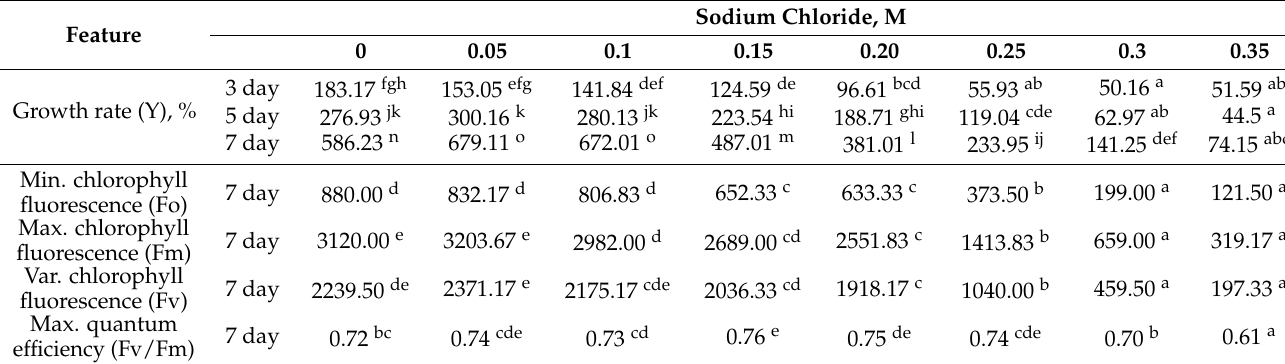
Table 2. The growth rate (Y), minimum chlorophyll fluorescence (Fo), maximum chlorophyll fluorescence (Fm), variable chlorophyll fluorescence (Fv) and maximum quantum efficiency (Fv/Fm) of algae Pseudokirchneriella subcapitata exposed to sodium chloride (NaCl). The table contains the mean of the examined features and in superscript the level of significance (a–o).